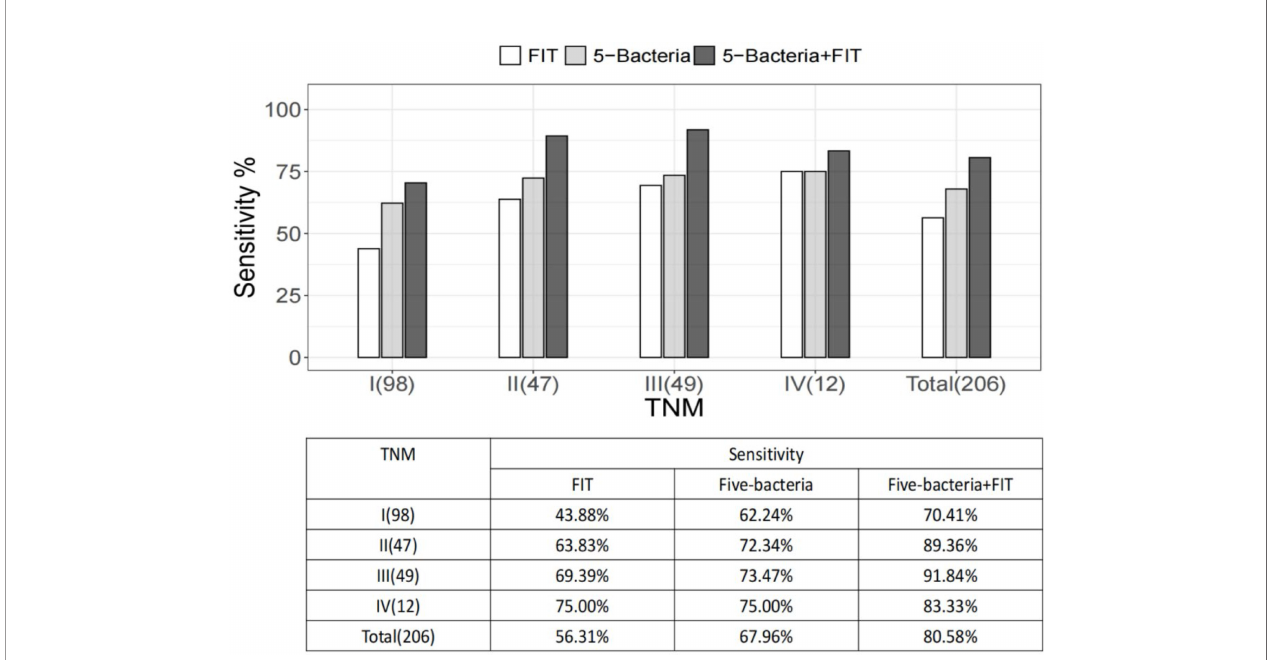
FIGURE 4 | Commercial fecal immunochemical test (FIT) and sensitivity to bacterial markers based on a subset of tumor-nodal-metastasis (TNM) stages. Shown also is the sensitivity of FIT and four bacteria, combined with the detection of colorectal cancer based on the tumor stage of colorectal cancer. The numbers in parentheses are the number of participants in each category.